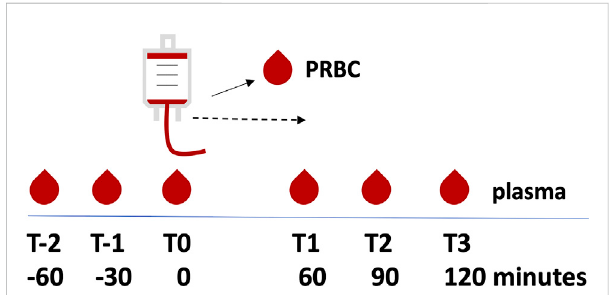
FIGURE 1 Overviewofsampling timepoints.Plasmawassampledat60,30, and 0 min before transfusion (T-2, T-1, and T0, respectively), followed by transfusion of one unit of packed red blood cells (PRBC) over 1 h +/ − 5 min. Plasma was then sampled at60, 90, and 120 min after the start of the PRBC transfusion (T1, T2, and T3, respectively). In addition, one sample was drawn from the PRBC unit. The dashed line indicates the transfusion